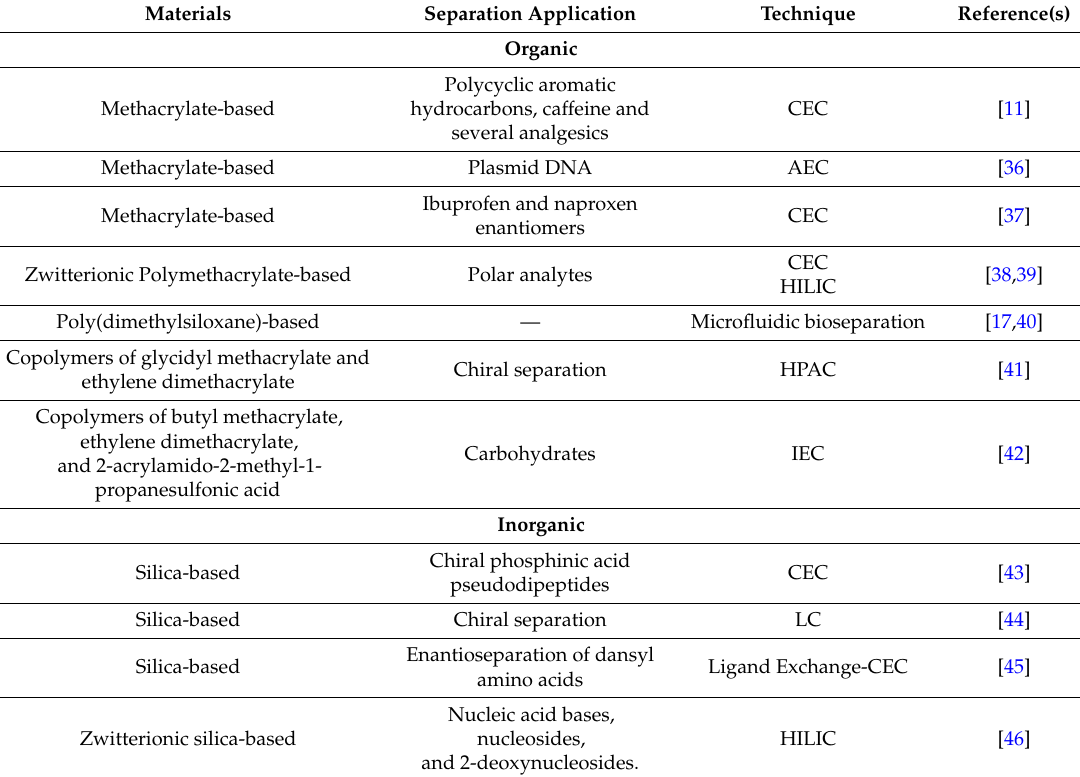
Table 1. Highlights of selected monolithic materials and